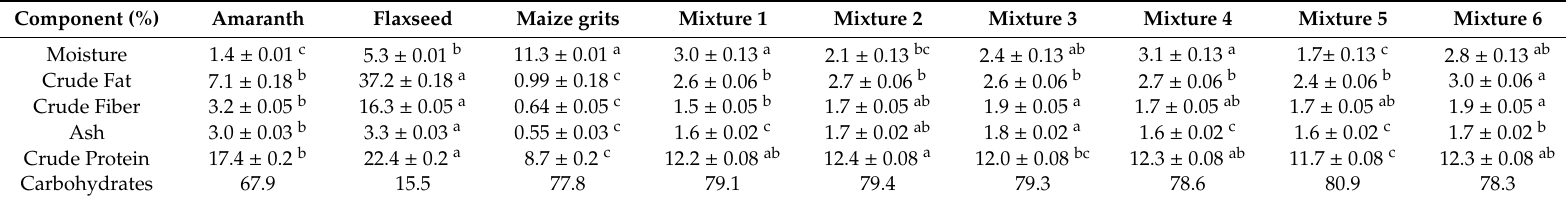
Table 2. Proximate composition of the raw materials and the extruded products *.